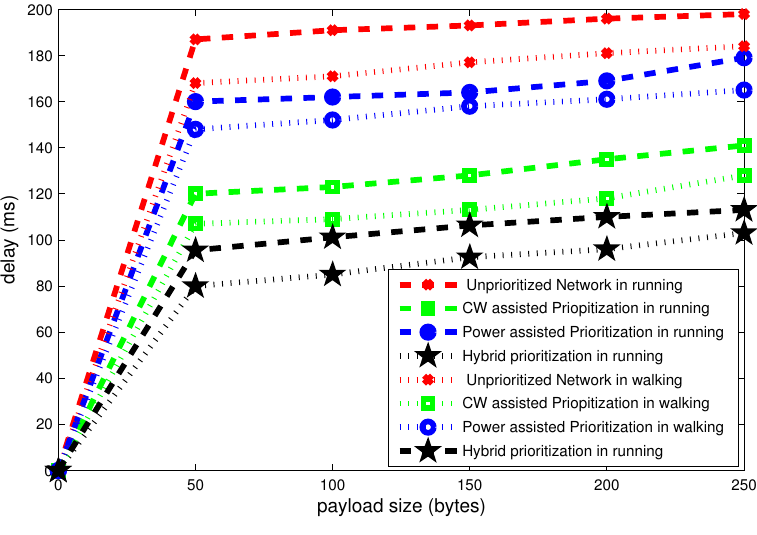
Figure 17. Effect of payload size on delay in mobile postures.